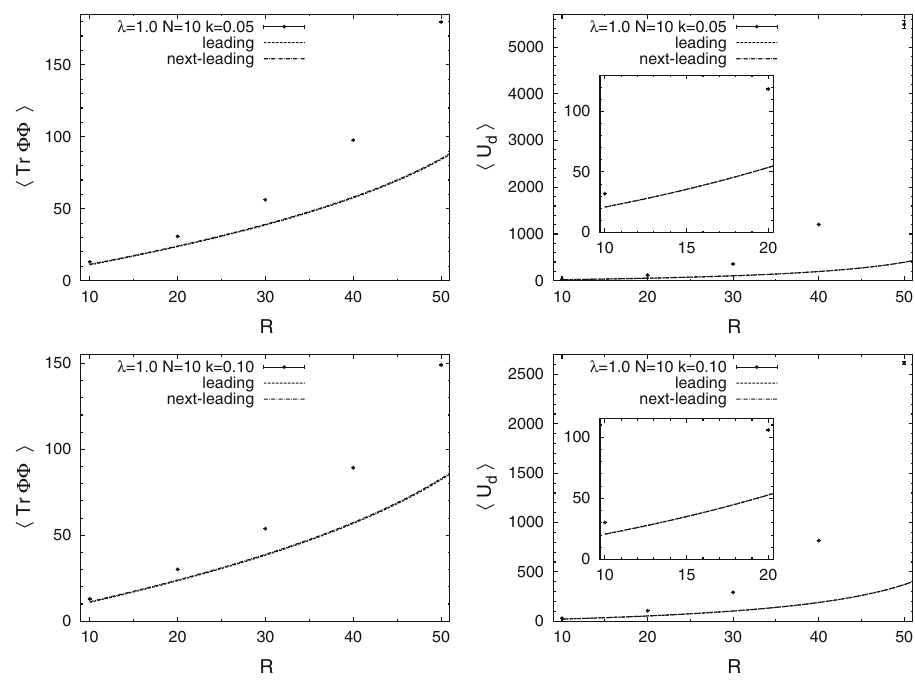
Fig. 6 Magnification of the small R regions that are unclear in Fig.